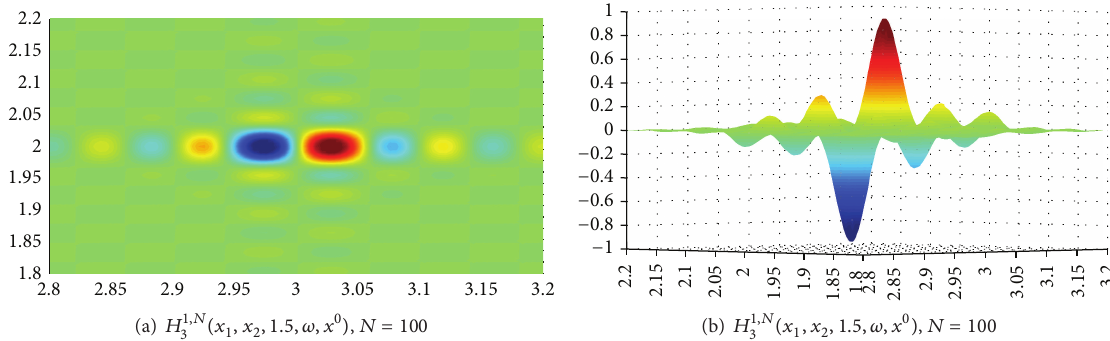
Figure 6: The third component of the first column of regularized magnetic Green’s function.